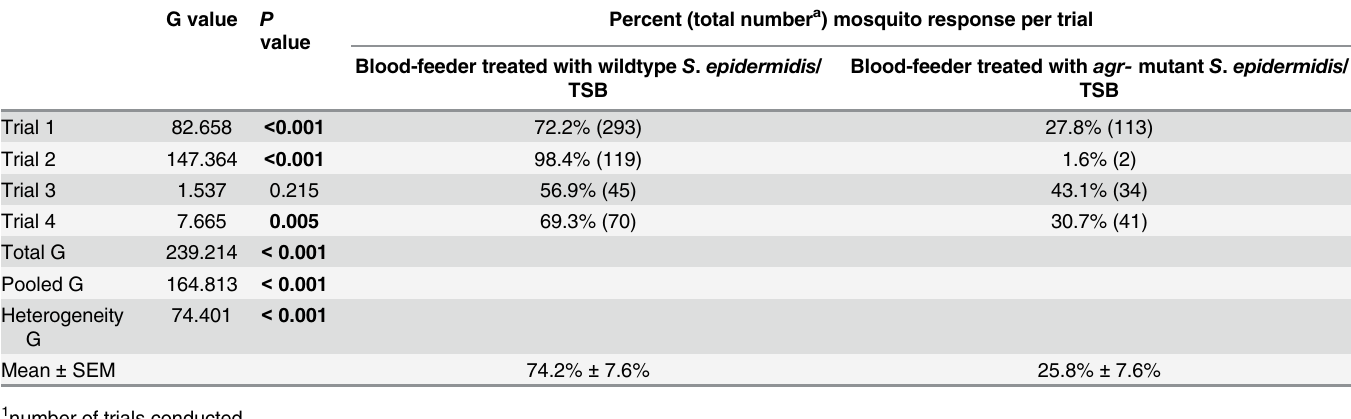
Table 4. Repeated G test of goodness-of-fit test, percent response per trial, and mean percent ± SEM across trials of the response of 5-8-d old Ae . aegypti (N 1 = 4; n 2 = 50) adult female attraction to blood-feeders located on opposite sides of the top of a 82 cm x 45 cm x 52 cm Plexiglas cage dur- ing 15-min experiments at 25°C and 80% RH and treated with wildtype S . epidermidis /TSB or agr- mutant S . epidermidis /TSB. G value P